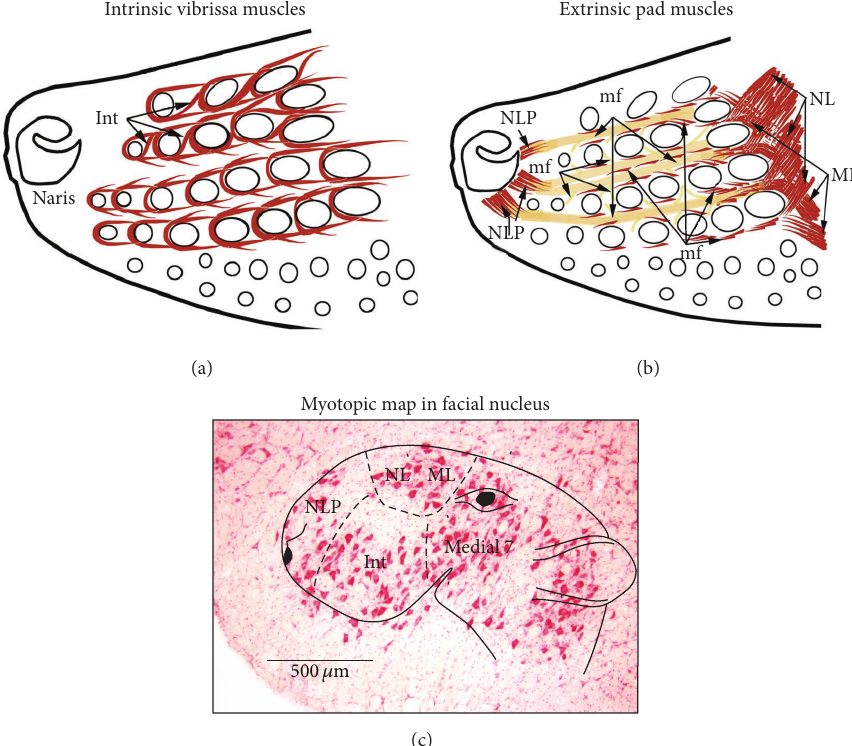
Figure 2: Facial muscles involved in exploratory behavior in rodents. (a) The intrinsic muscles (Int) form a sling around the base of vibrissa follicles. When they contract, vibrissae protract. (b) Two groups of extrinsic muscles translate the mystacial pad: muscle nasolabialis (NL) and maxillolabialis (ML) retract the pad, while muscle nasolabialis profundus (NLP) protracts the pad. Extrinsic muscle fibers (mf) run underneath the skin between vibrissa rows. (c) Motoneurons that innervate the intrinsic vibrissa muscles are located in the ventral lateral part of the facial nucleus, the extrinsic retractor muscles (nasolabialis and maxillolabialis) are represented dorsolaterally, and the extrinsic protractor muscles (nasolabialis profundus) are represented at the lateral most edge of the nucleus. The drawings in (a) and (b) were adapted from Figure 11 of Grant et al.